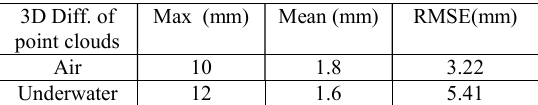
Table 4. Difference between 3D point clouds from Lumix and GoPro camera systems of calibration scenes in air and underwater.